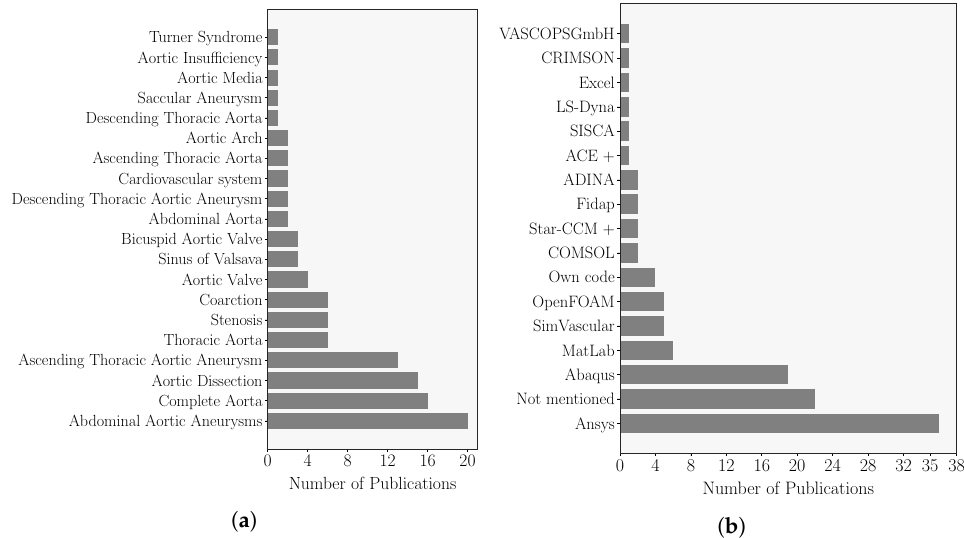
Figure 3. ( a ) Studied anatomical regions. ( b ) Selected software to perform the numerical modelling.